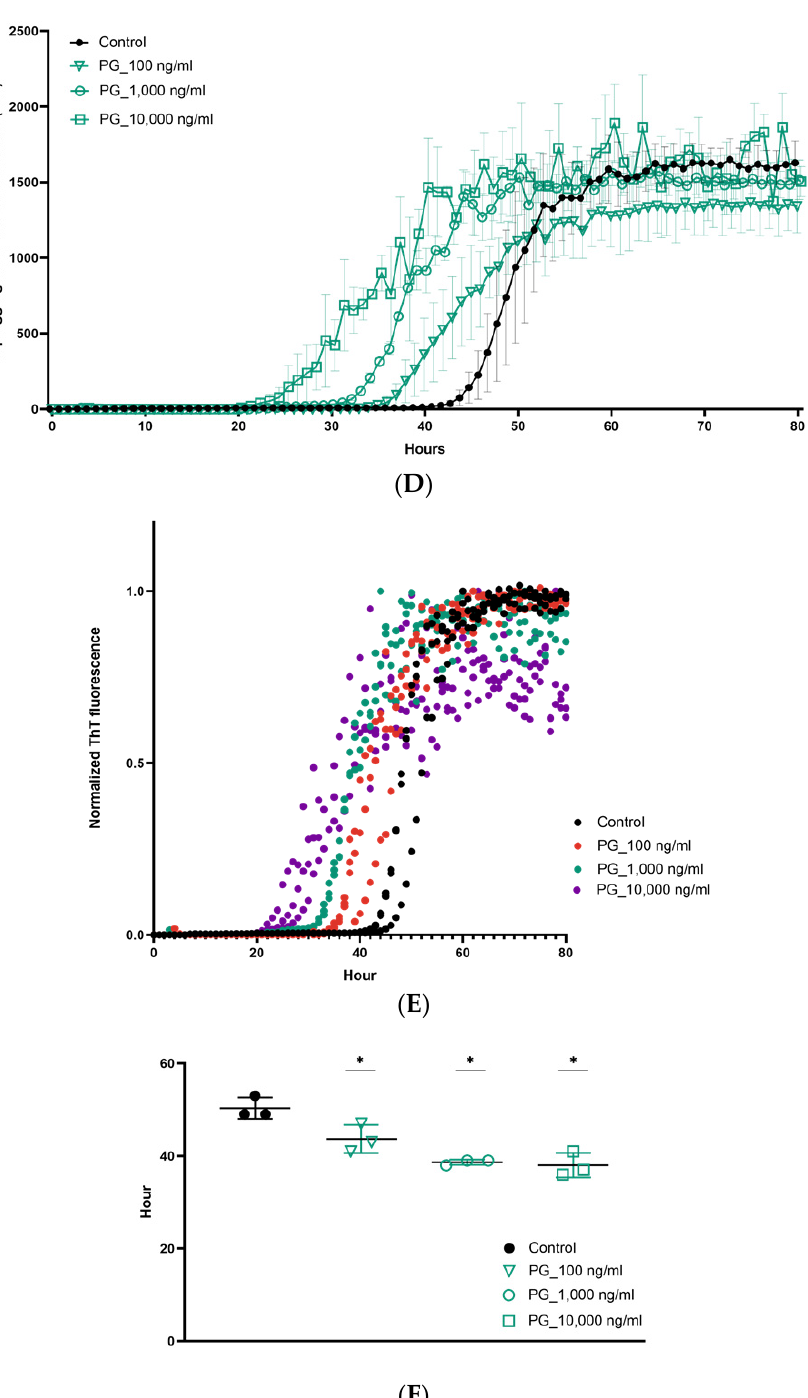
Figure 3. Dose-dependent effect of eDNA on amyloid β (A β ) aggregation. Dose-dependent effect of DNA from Escherichia coli ATCC29522 and Porphyromonas gingivalis on A β aggregation. Effect of the eDNA of E. coli ATCC29522 on ( A ) the aggregation of ThT fluorescence as a function of time, ( B ) normalized ThT fluorescence (relative aggregate concentration) as a function of time (h), and ( C ) t1/2 values of the aggregation. Effect of the eDNA of P. gingivalis on ( D ) the aggregation of ThT fluorescence as a function of time, ( E ) normalized ThT fluorescence (relative aggregate concentration) as a function of time (h), and ( F ) t1/2 values of aggregation. For the images ( A , C , D , F ) symbols represent averages and error bars represent the standard deviation of experiments performed in triplicate. * p ≤ 0.05; For the images ( B , E ) all replicates from three experiments are shown in the plot.